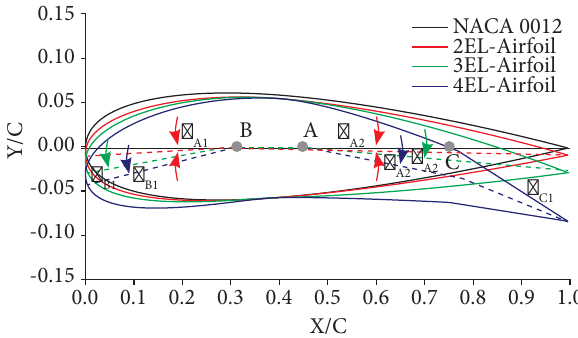
Figure 1. Representation of discrete element morphing.